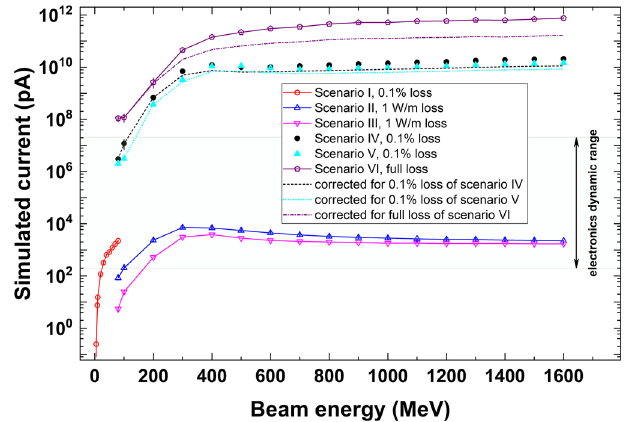
FIG. 24. Simulated ionization current for scenarios IV and V with a 0.1% loss and scenario VI with full loss, and the dashed lines correspond to the corrected current due to the space charge